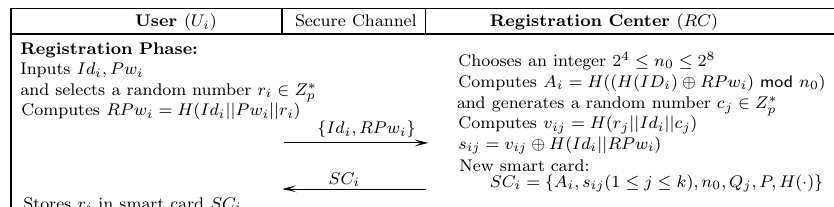
Figure 2. Server registration.